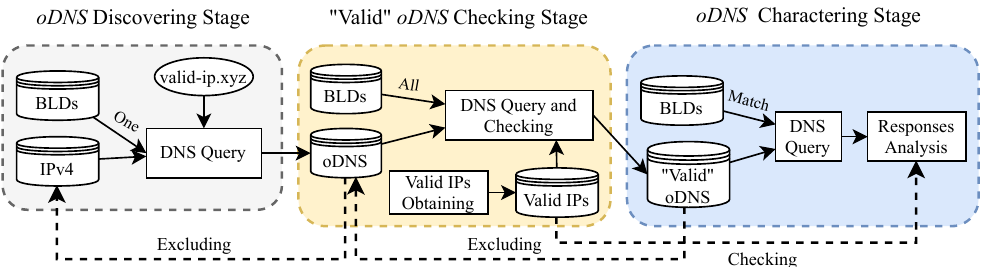
Figure 2. Processing chain of discovering and characterizing open DNS